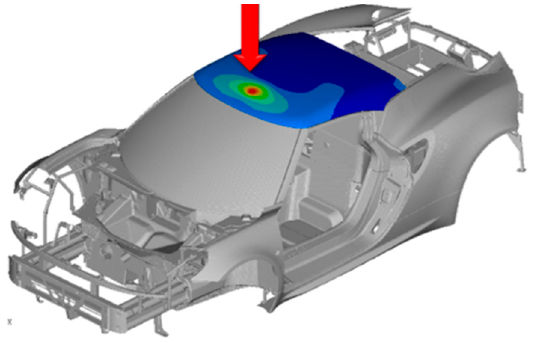
Figure 12. Displacement of point 1 of the pavilion of 4C car. Static stiffness was calculated for the nine points for the three materials, i.e., SMC, TCA and PP23CF (Figure 13).